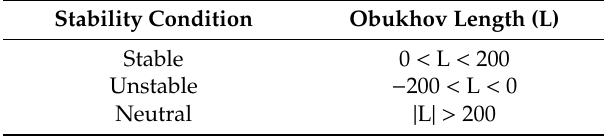
Table 1. Stability condition with respect to Obukhov length [22,23].